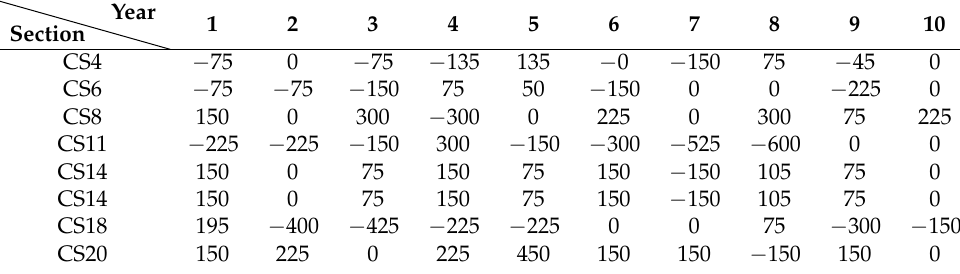
Table 4. Swing distance of each section year by year with four river training projects (unit: m). Year Section